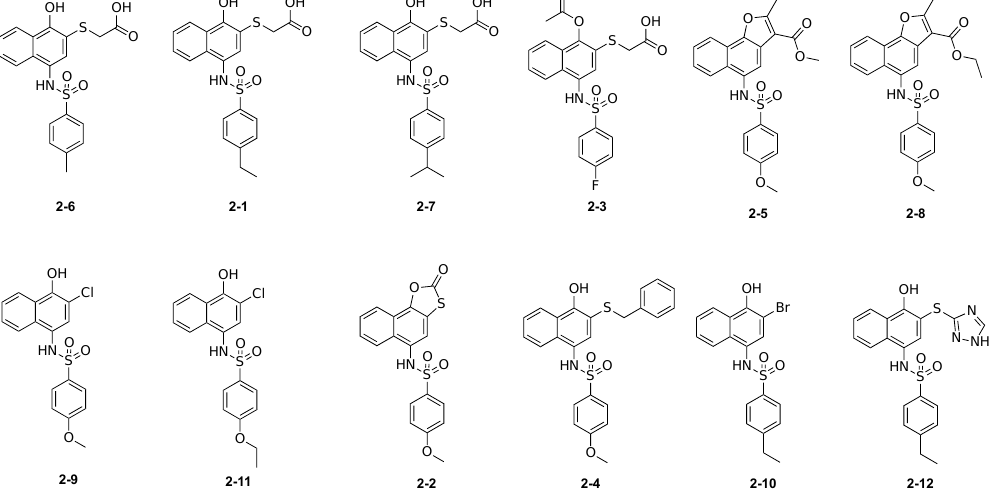
Table 3. Inhibition rates of analogs of 2-5 and 2-8 identified by 2D similarity search (Part 1).